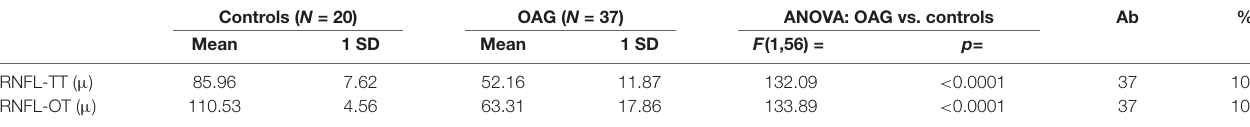
TABLE 2 | Mean values of retinal nerve fiber layer (RNFL) thickness detected in controls and in patients with open-angle glaucoma (OAG). Controls ( N = 20) OAG ( N = 37) ANOVA: OAG vs.